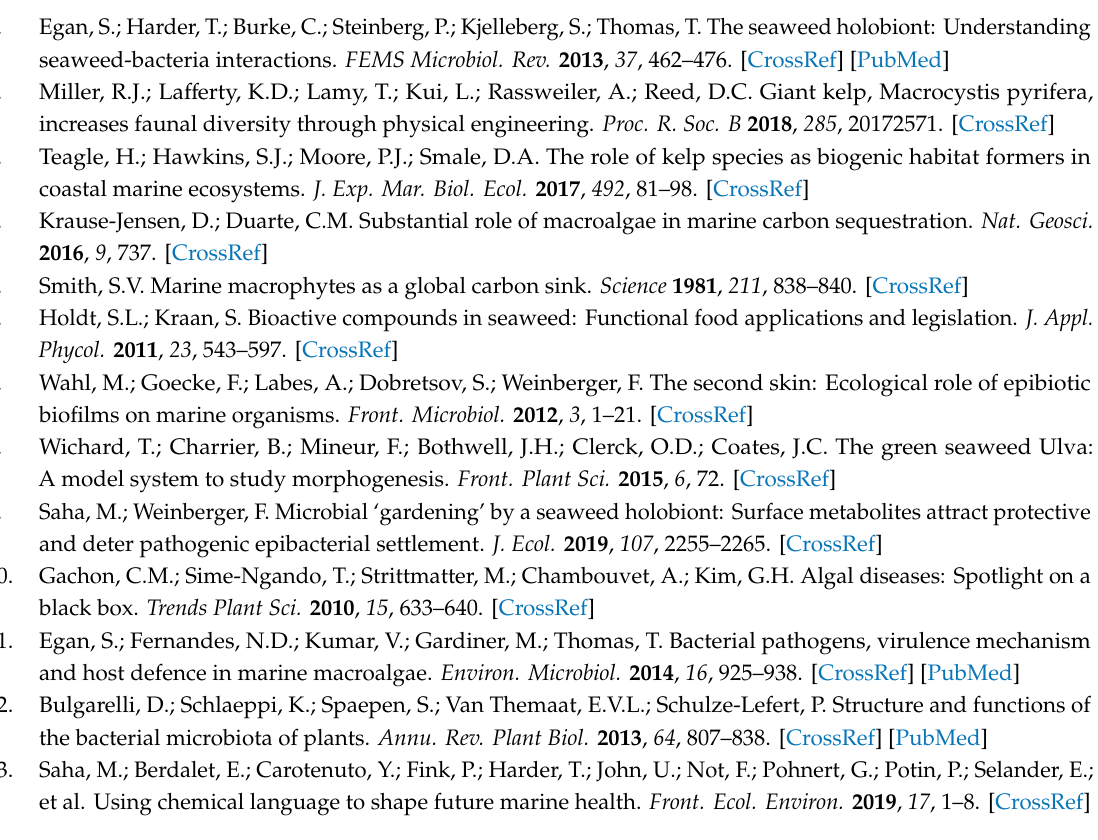
Figure S1: Wet weight of Agarophyton vermiculophyllum between start and end of the experiment at both salinity levels. Error bars ± CI ( n = 5). Raw data for defence capacity test are available